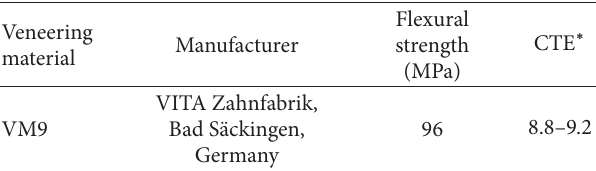
Table 2: Firing schedules of zirconia (as provided by the manufac- turer).